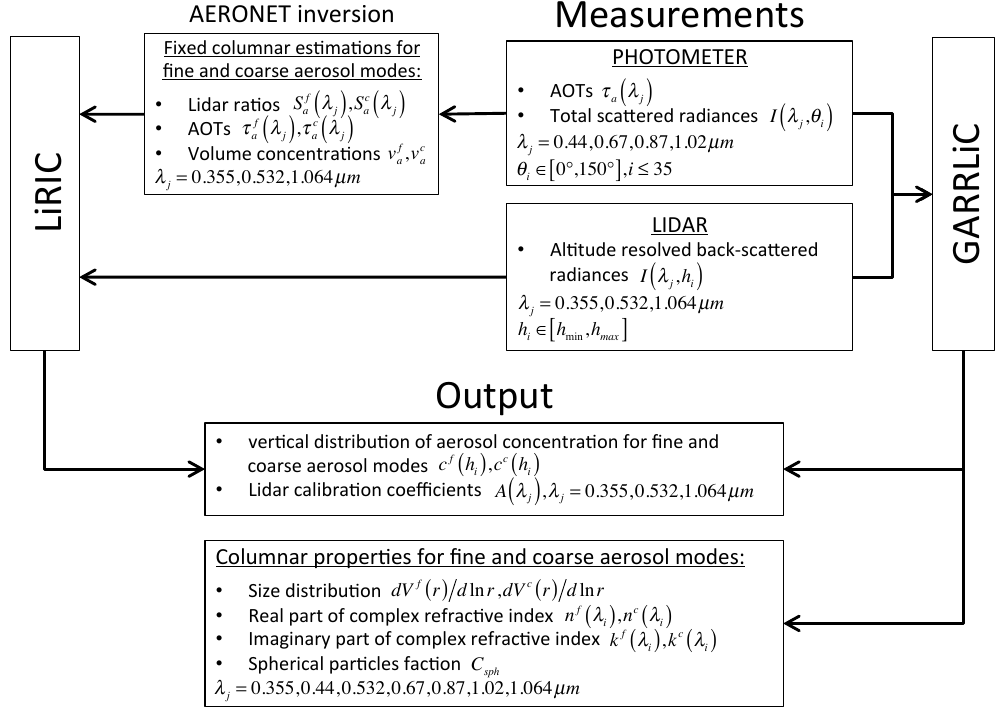
Fig. 1. Comparison of LiRIC and GARRLiC